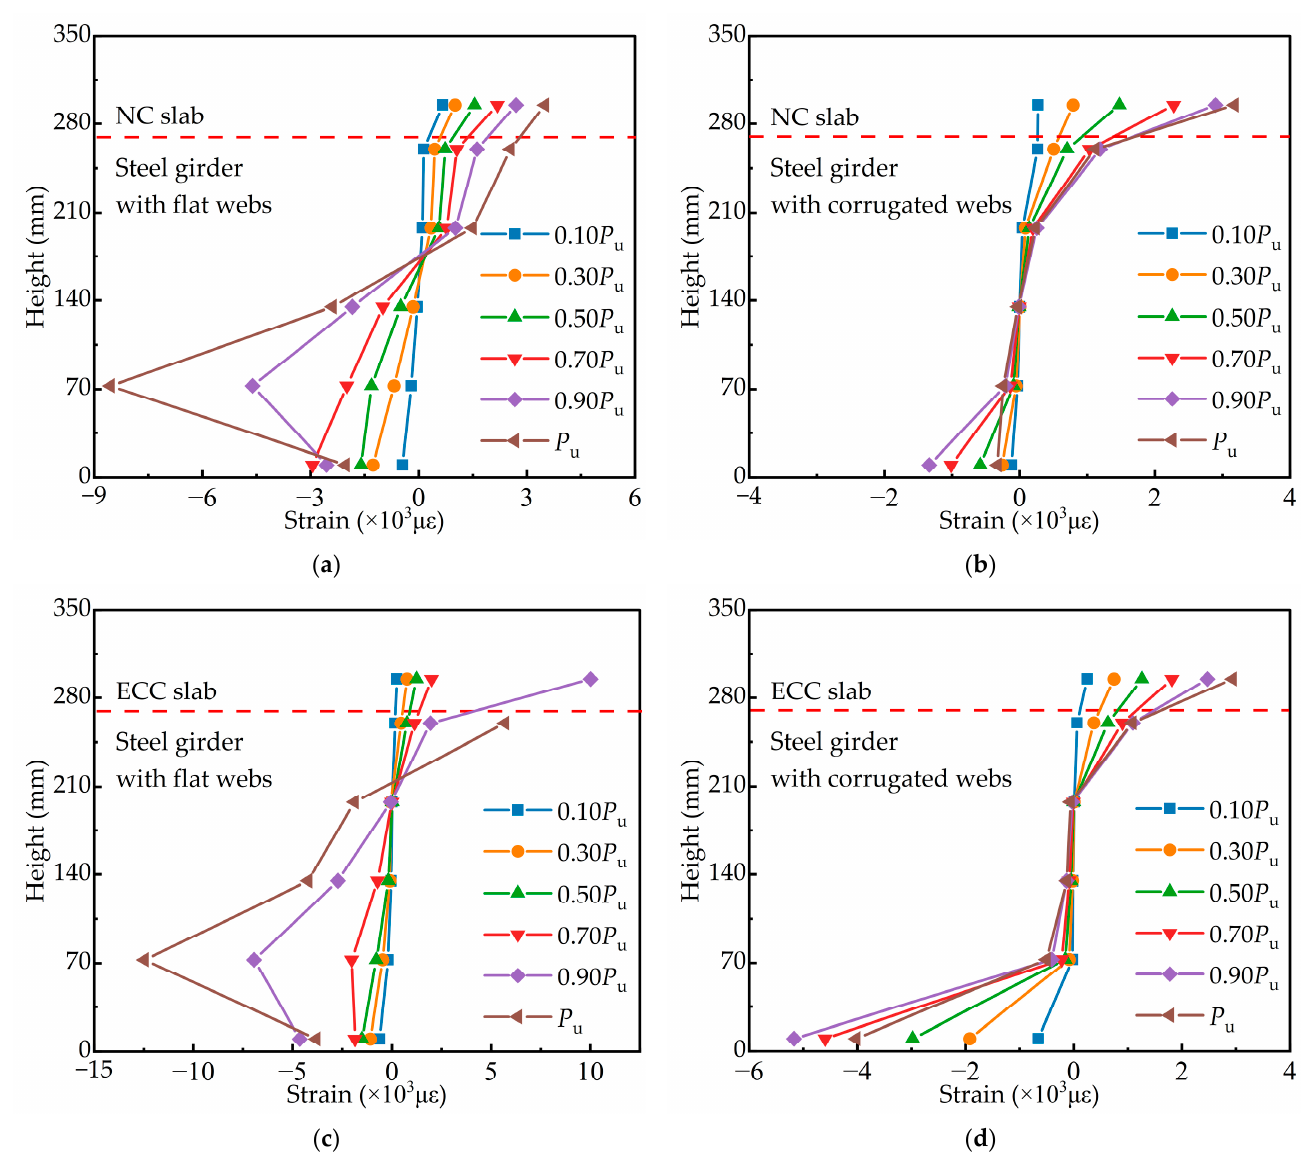
Figure 7. Strain distribution along the height: ( a ) specimen SNF; ( b ) specimen SNC; ( c ) specimen SEF; ( d ) specimen SEC.